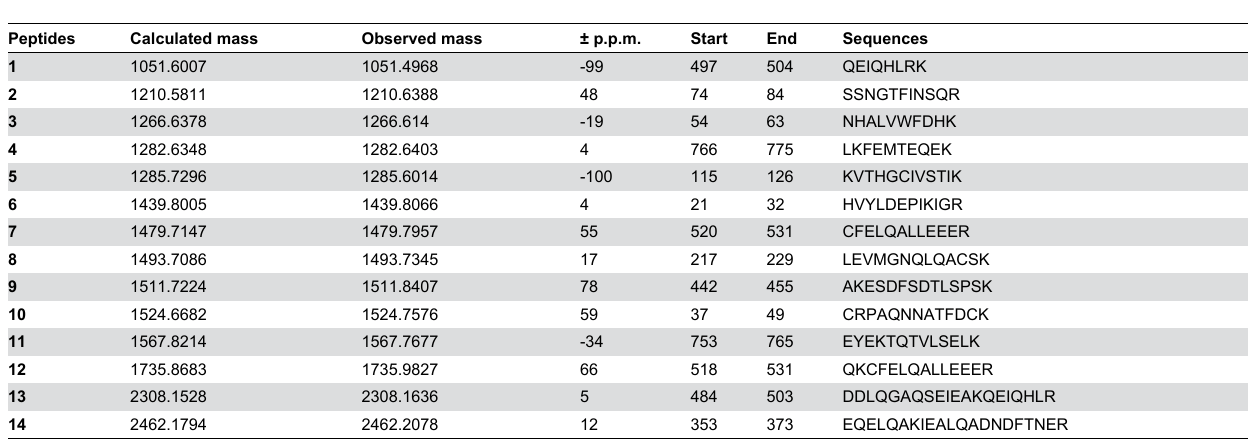
Table 1. SLMAP specific peptides identified by mass spectrometry.